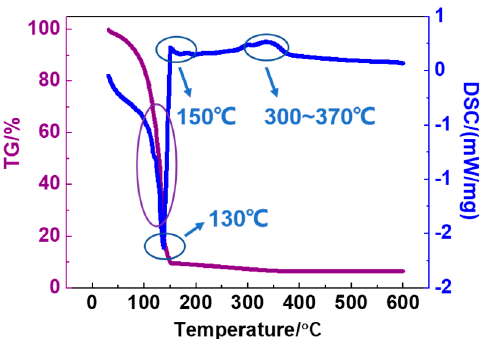
Figure 2. Thermal behavior of In x Zr y O precursor solution (Zr:In = 15 at.%) analyzed by thermogravimetry-differential scanning calorimetry (TG-DSC).